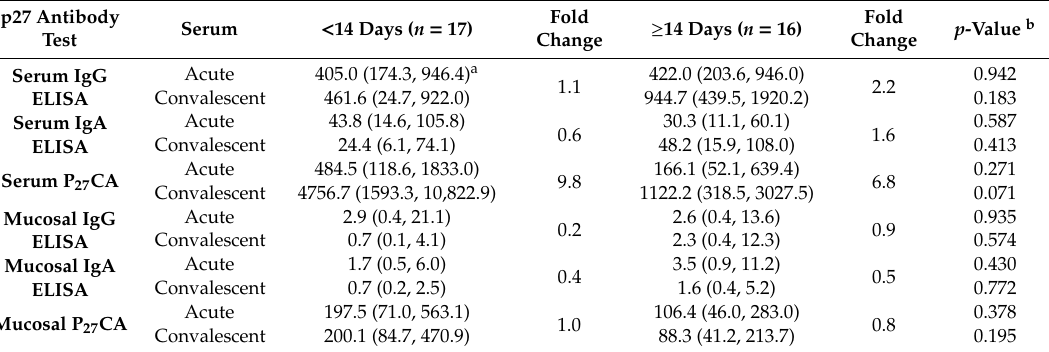
Table 3. p27 antibody concentrations in RSV infected HCT adults who shed RSV < 14 days and ≥ 14 days. p27 Antibody Test